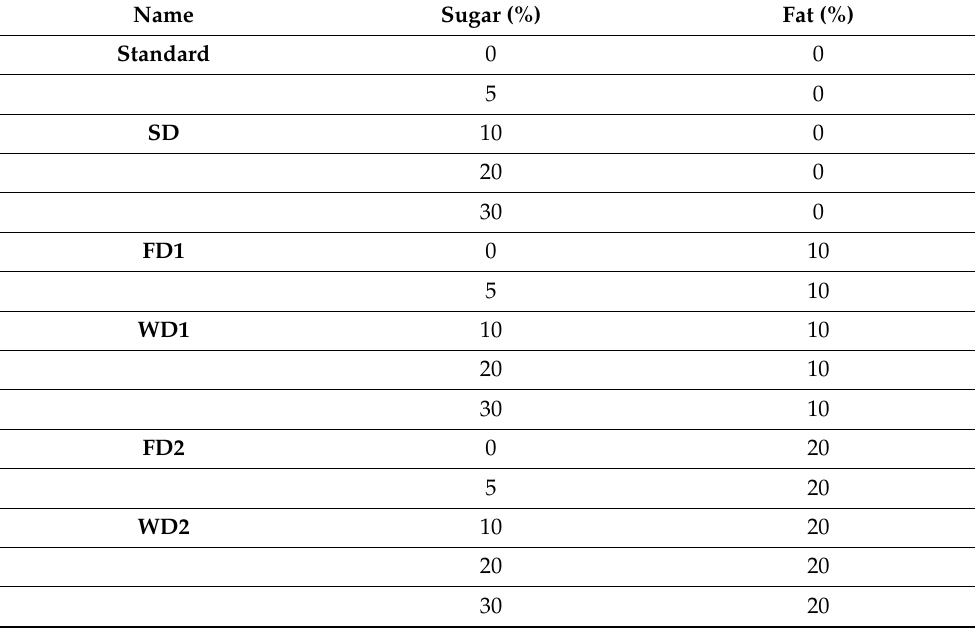
Table 1. Materials and